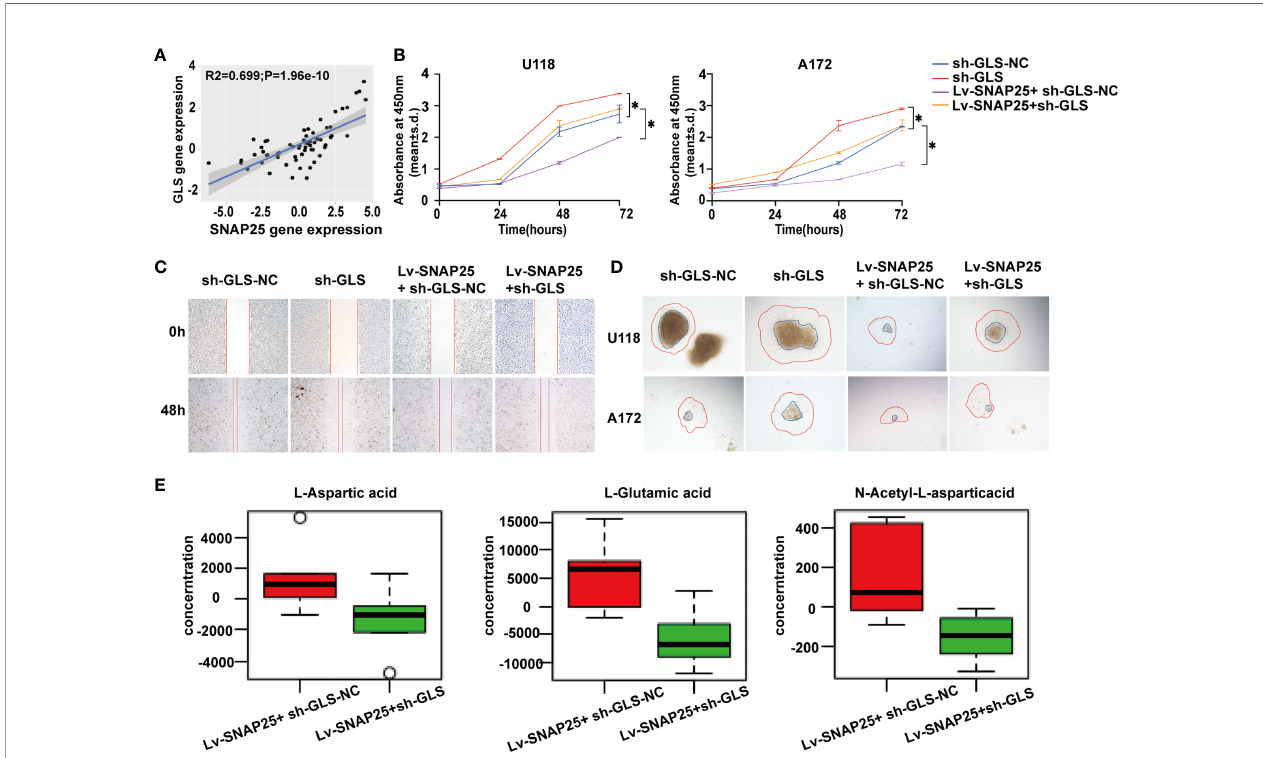
FIGURE 6 | GLS is positively correlated with SNAP25. (A) Correlation analysis of SNAP25 and GLS by Pearson ’ s correlation coef fi cient. P -value is given on the fi gure. (B) CCK-8 assay of U118 and A172 glioma cells when transfected with Lv-NC, Lv-SNAP25 and/or sh-GLS-NC, sh-GLS, * p < 0.05 compared with Lv-NC or sh-GLS-NC group. (C, D) Wound healing assay and cancer cell spheroid invasive assay of U118 and A172 glioma cells when transfected with Lv-NC, Lv-SNAP25 and/or sh-GLS-NC, sh-GLS. (E) The concentration of L-Aspartic acid, L-Gluatamic acid, and N-Acetyl-L-aspartic acid from LC-MS data obtained for Lv-SNAP25 glioma cells transfected with sh-GLS-NC or